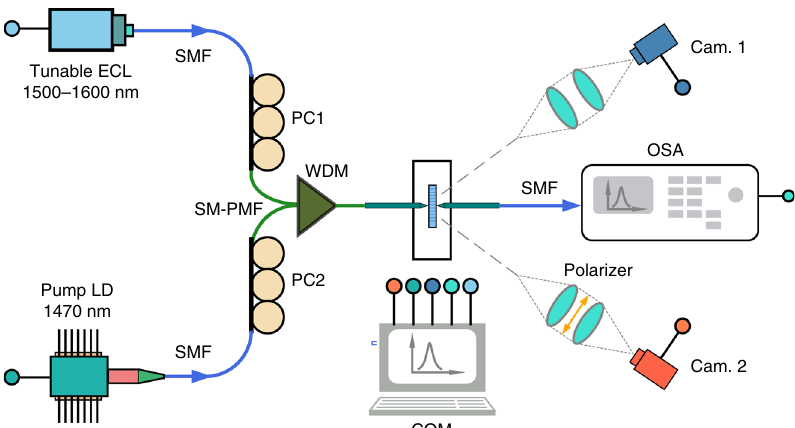
Fig. 7 Edge-coupling waveguide measurement setup. The components in the setup are as follows: ECL: external cavity laser, SMF: single-mode fi ber, PC: polarization controller, LD: laser diode, WDM: wavelength-division multiplexer, SM-PMF: single-mode polarization-maintaining fi ber, Cam: camera, OSA: optical spectrum analyzer, COM: